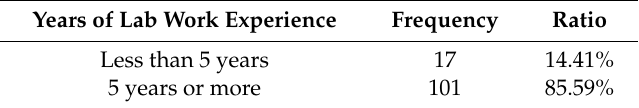
Table 6. Descriptive statistical analysis of teachers’ lab work experience